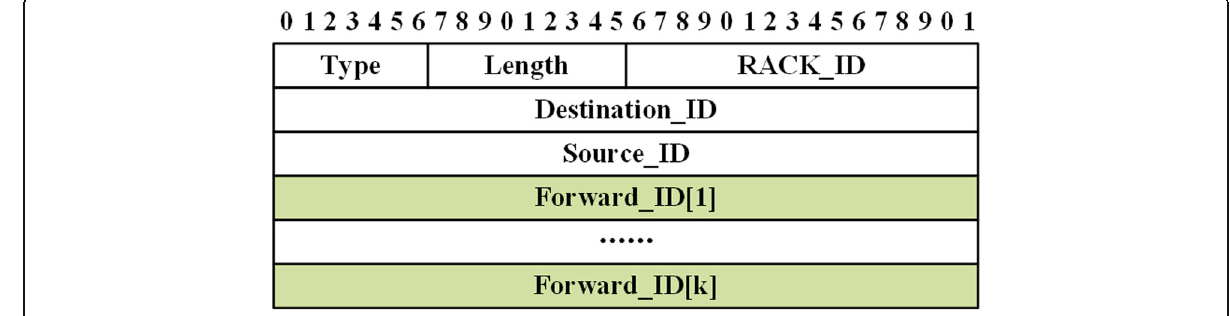
Fig. 17 Structure of RACK Message. Figure 17 shows the structure of RACK message, including the name of fields and their length